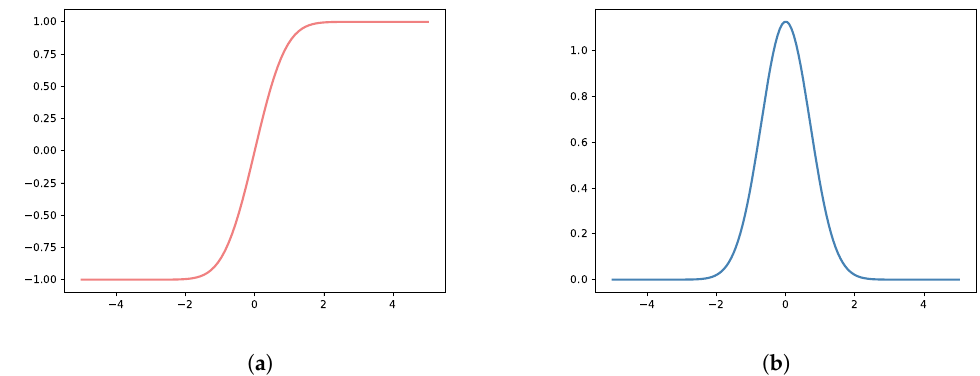
Figure 4. Diagram of Gaussian error function and its derivative. ( a ) Gaussian error function. ( b ) The derivative of the Gaussian error